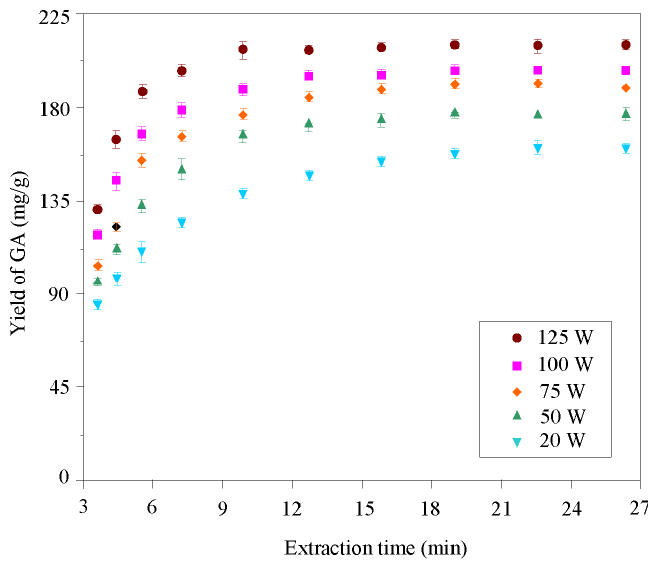
Figure 1. Evolution of extraction yields of glycyrrhizic acid with different ultrasonic powers at an extraction temperature of 25 °C and ultrasonic frequency of 20 kHz.